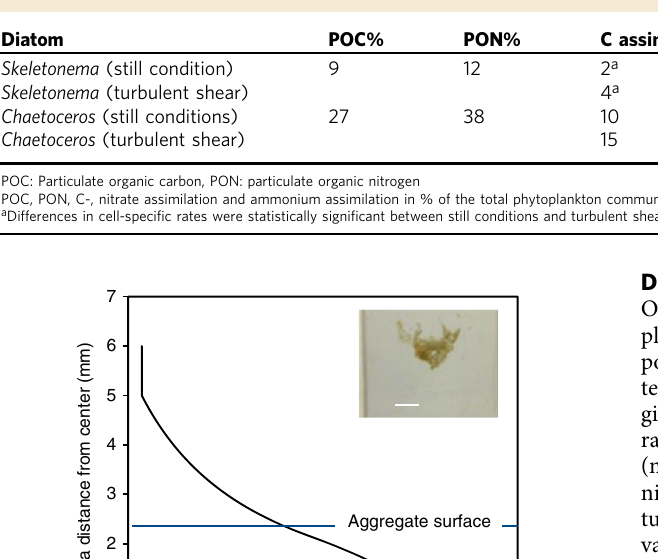
Table 3 C and N assimilation associated to Skeletonema and Chaetoceros